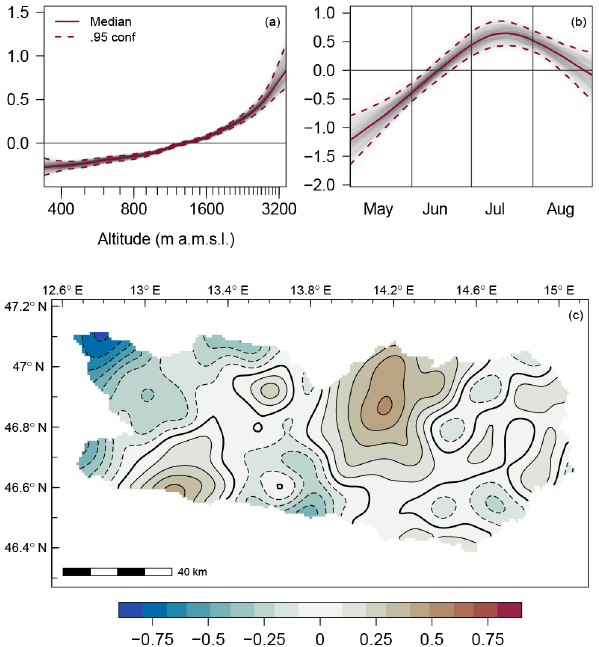
Figure 4. The effects of the occurrence model on the scale of the ad- ditive predictor. (a) The altitude (logalt) effect. Ticks on the x axis are set in 100m intervals. The grey lines show 1000 estimates from day-wise block-bootstrapping. The solid red line is the median of the 1000 estimates, the dashed red lines are the 95% confidence in- tervals. (b) The seasonal (doy) effect. (c) The spatial (lon,lat) effect. The plot shows the median of 1000 estimates from day-wise block- bootstrapping. The difference between two contour lines is 0.1. Dashed contour lines indicate negative values.